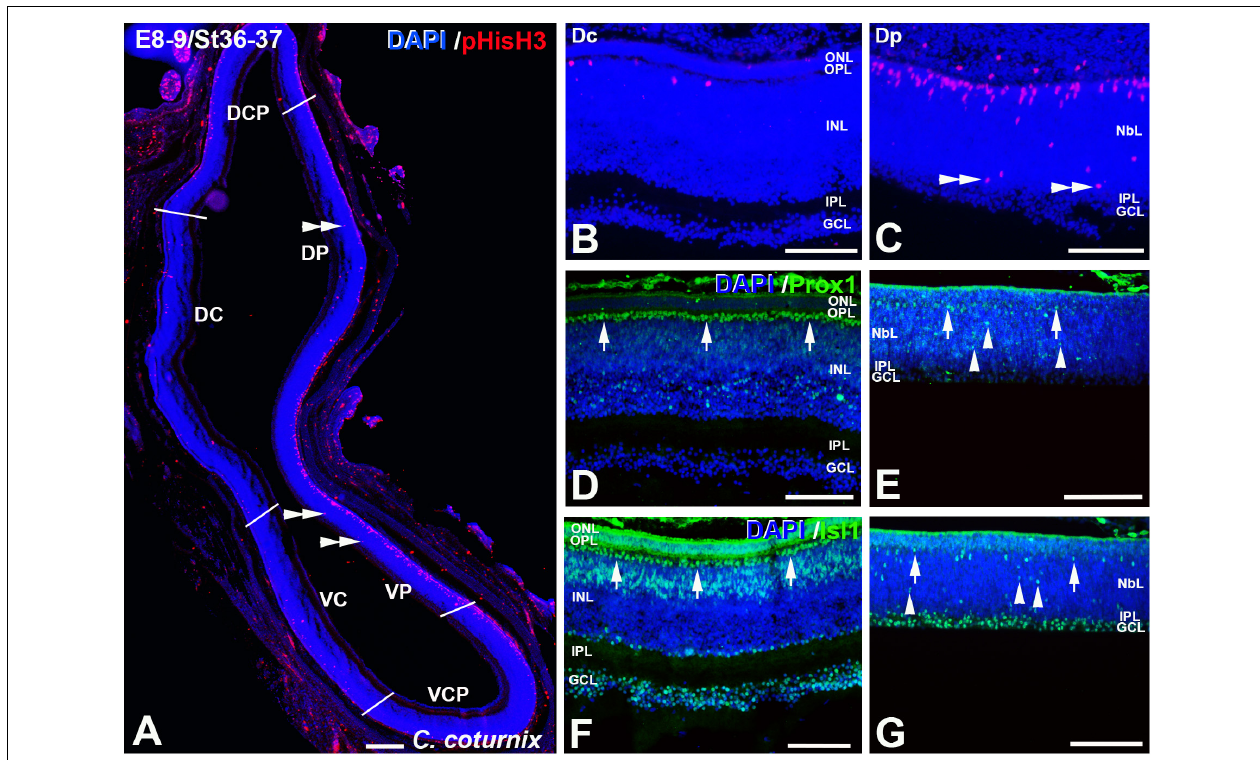
FIGURE 10 | pHisH3 (A–C) , Prox1 (D,E) , and Isl1 (F,G) immunolabeling in the C. coturnix retina at E8-9 (St36-37). Cryosections were counterstained with DAPI. (A–C) Non-apical mitosis were mainly located in the Dp and Vp sectors (double arrowheads). Apical mitoses were scarce in the Dc (B) , Dcp, Vc, and Vcp sectors (A) . (D–G) Abundant Prox1- [arrows in panel (D)] and Isl1- [arrows in panel (F) ] immunoreactive nuclei were detected in the horizontal cell layer in the Dc sector, but also in the amacrine cell layer (D,F) and in the GCL (F) . More immature staining patterns were found in the Dp sector, with sparse immunoreactive nuclei located in the presumptive horizontal cell layer [arrows in panels (E,G) ] but also in more internal regions of the NbL [arrowheads in panels (E,G) ]. Abbreviations: GCL, ganglion cell layer; INL, inner nuclear layer; IPL, inner plexiform layer; NbL, Neuroblastic layer; ONL, outer nuclear layer. Scale bars: 100 µ m in panel (A) ; 50 µ m in panels (B–G)